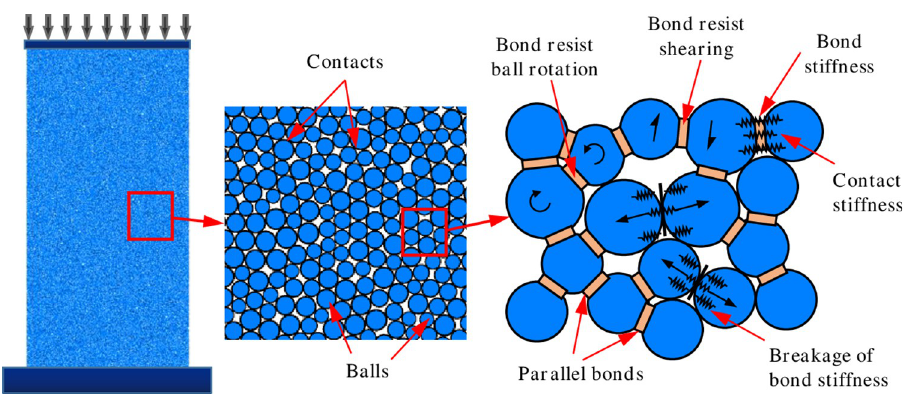
Fig 2. Typical numerical model and the parallel bond contact in PFC2D.